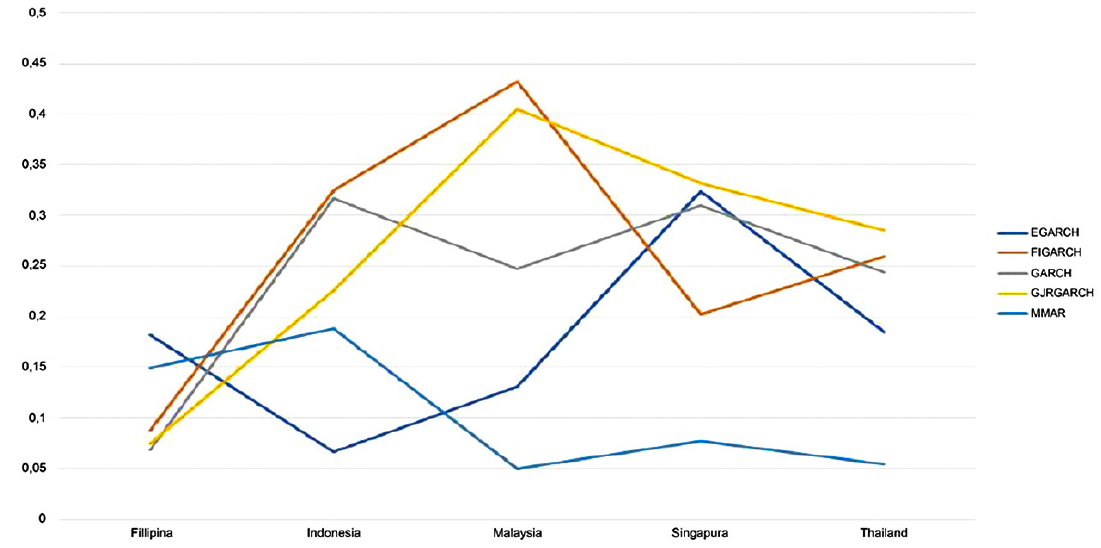
Figure 4. The path of standard deviation shows the MMAR model has the smallest value compared to other